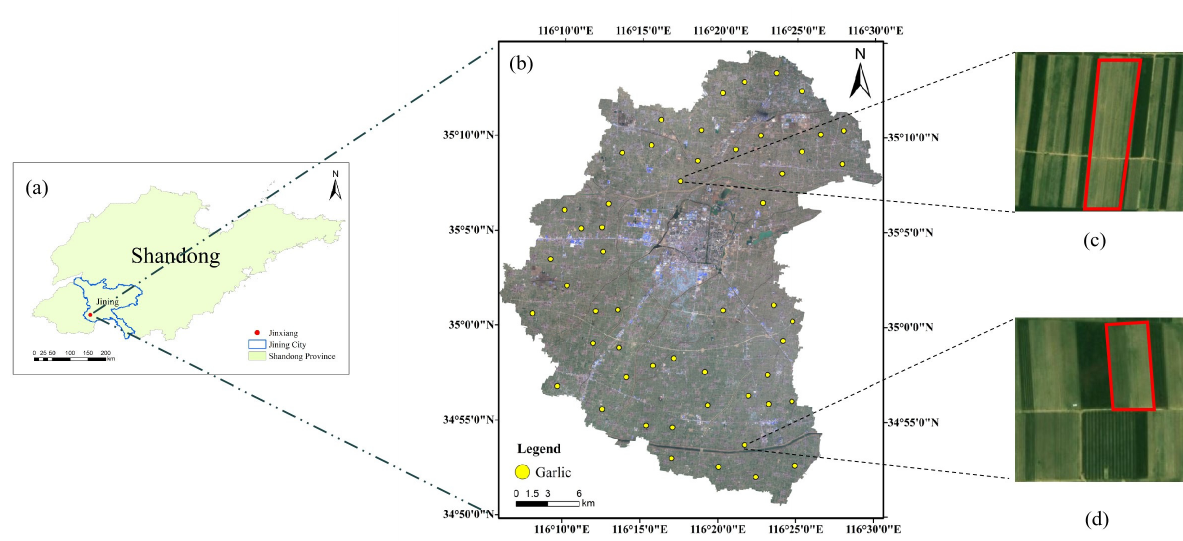
Figure 1. ( a ) The location of the study area; ( b ) the spatial distribution of garlic sample data on the satellite image from 9 February 2020 (true-color composite of the blue, green, and red bands of Sentinel-2 image); ( c , d ) the garlic sample data on the Google Earth satellite images.